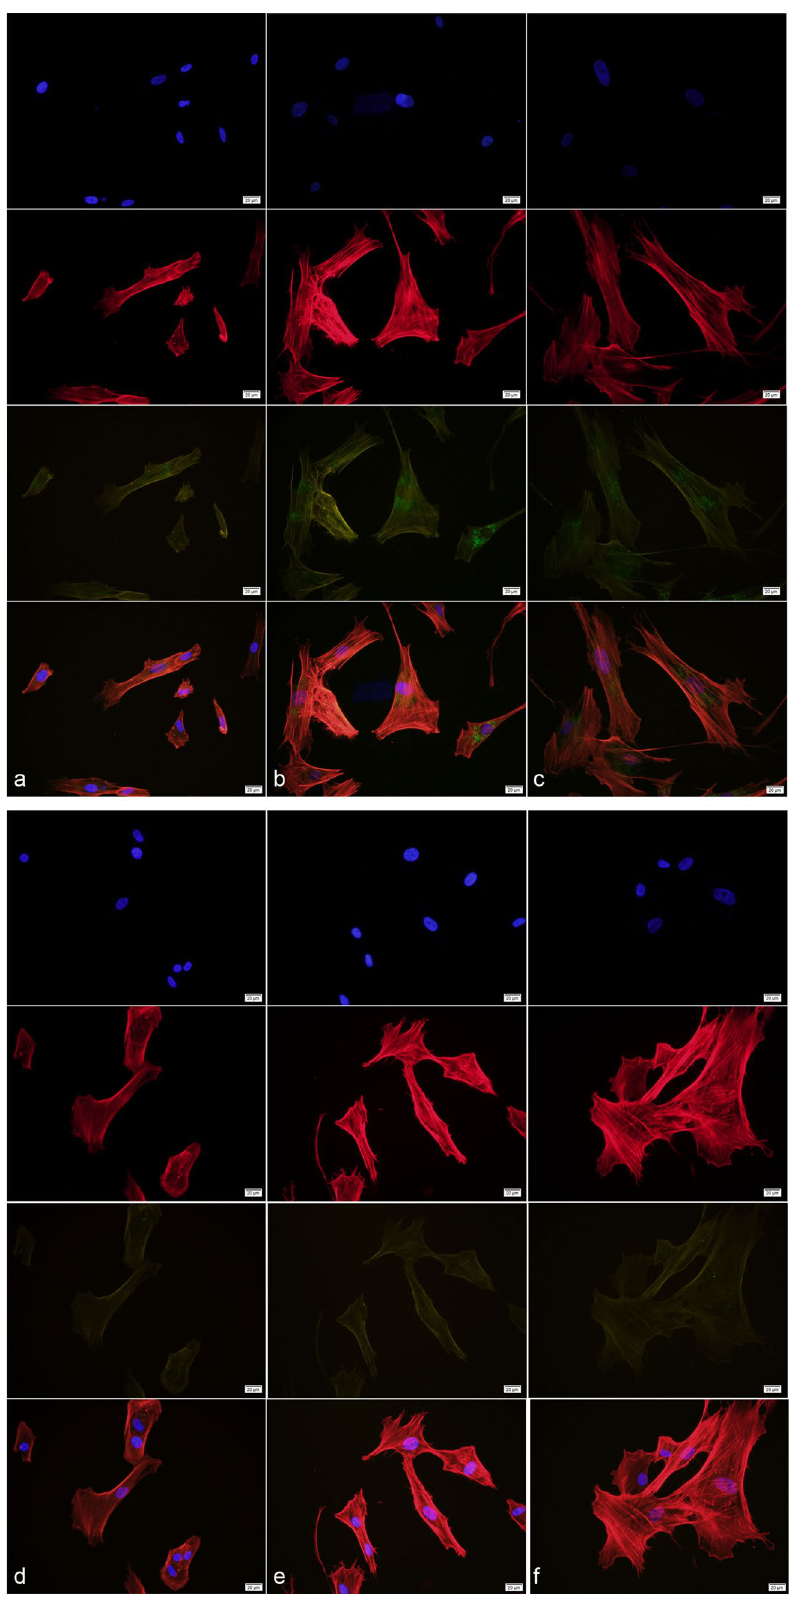
Figure 2. HTMCs uptake hBMSC-derived exosomes in different periods. HBMSC-derived exosomes were labeled with PKH67 (green), hTMCs nucleus were labeled with DAPI(blue), cytoplasm were labeled with phalloidine (red). HTMCs were incubated with hBMSC-derived exosomes for ( a ) 6 h, ( b ) 12 h, and ( c ) 24 h, respectively. Controls were incubated with dye only for ( d ) 6 h, ( e ) 12 h, and ( f ) 24 h,